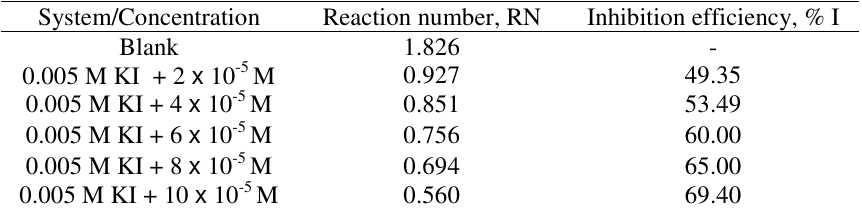
Figure 4. Variation of temperature with time for the dissolution of aluminium in the absence and in different concentrations of nizoral + KI mixture. Table 2. Calculated values of Reaction Number (RN) and Inhibition efficiency (% I) in the absence and presence of different concentrations of nizoral+ iodide